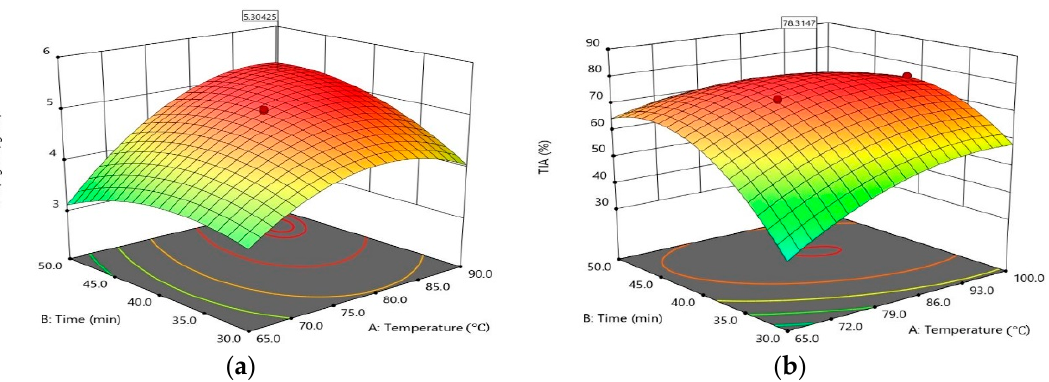
Figure 2. ( a ) Surface response curve on extraction of TPC of mealworm extract. Interactive effects of extraction temperature and extraction time at fixed level of ethanol concentration of 61.3 v / v %; ( b ) Surface response curve on TIA of mealworm extract. Interactive effects of extraction temperature and extraction time at fixed level of ethanol concentration of 61.3 v / v %.